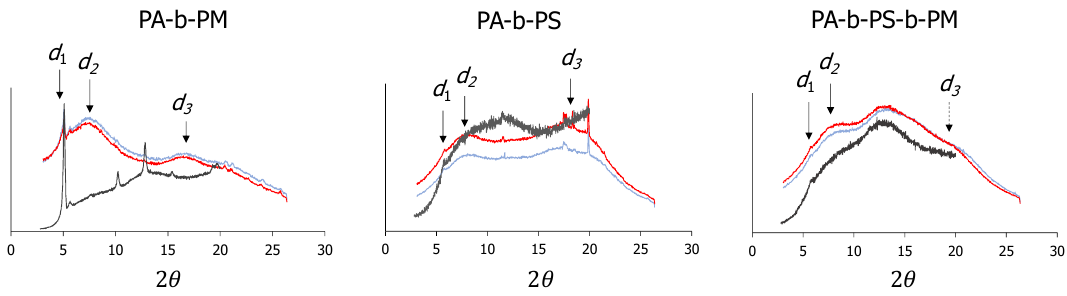
Figure 5. SAXS scatterings (obtained at 85 °C, red; at room temperature, 25 °C, blue) and XRD diffractograms (obtained at room temperature, 25 °C, grey) of the block copolymers forming liquid crystalline phases, highlighting relevant reflections related to the spacings found in Figure 4, d i . Y-axes correspond to the diffractogram intensity, a.u.; and curves have been shifted arbitrarily along this axis. We have indicated in the PA-b-PS-b-PM curve the underlying d 3 spacing associated to the distance between azobenzene units in the copolymer chains. Table 3. Summary of the main reflections obtained from the XRD and SAXS diffractograms, measured at room temperature (T = 25 °C). Colours indicate the tentative origin of the reflection.